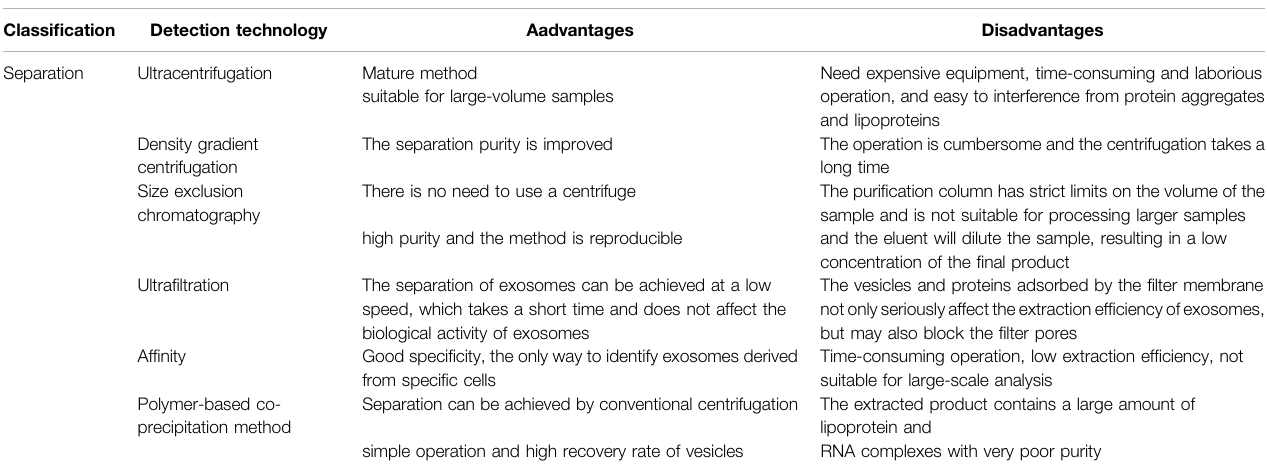
TABLE 1 | The separation and identi fi cation techniques for